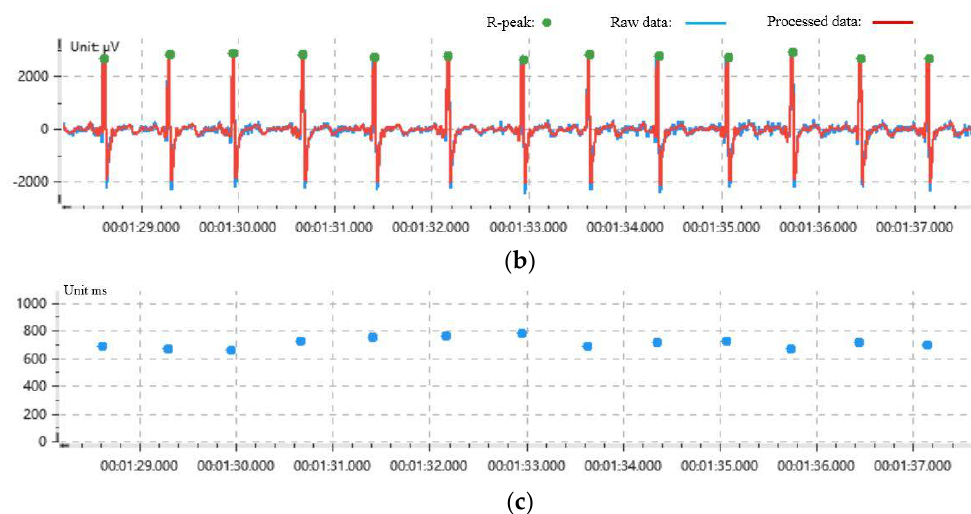
Figure 2. ECG Preprocessing. ( a ) ECG signal data before and after denoising. ( b ) The results of R-peaks extraction. ( c ) The results of RR intervals.